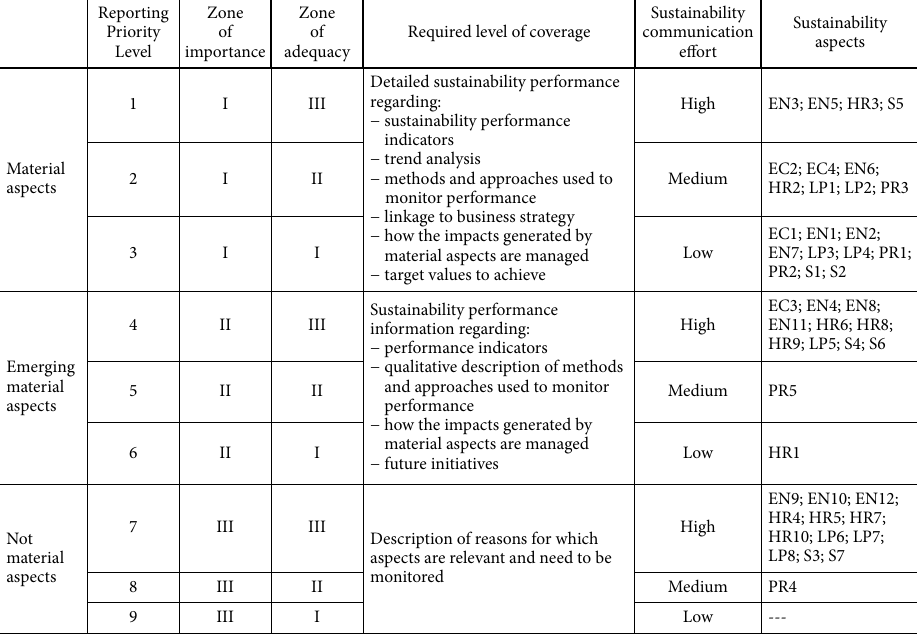
Table 5. Level of coverage for each reporting priority